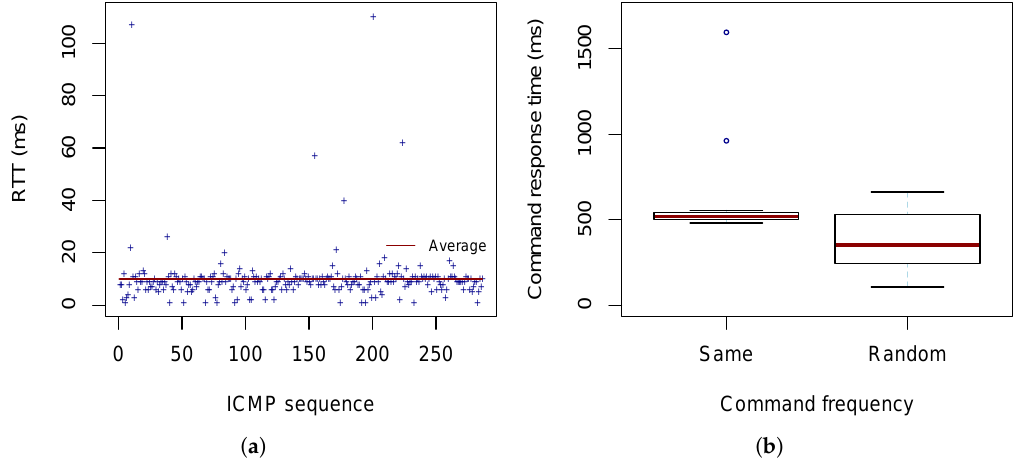
Figure 4. Investigation of delays: ( a ) RTT (round trip time) recorded over a period of five minutes (286 ICMP messages) and ( b ) command response time with a constant inter-command time of 2s (same frequency) and an inter-command time randomly distributed in the interval of [ 2,2.5 ] s (random frequency). The red middle line in the box plots corresponds to the median, and the upper and lower borders of the box visualize the 25% and the 75% quartiles, respectively.